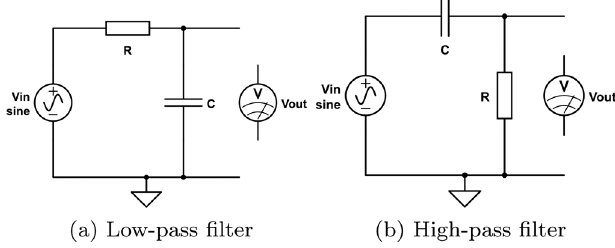
FIG. 1. First order RC